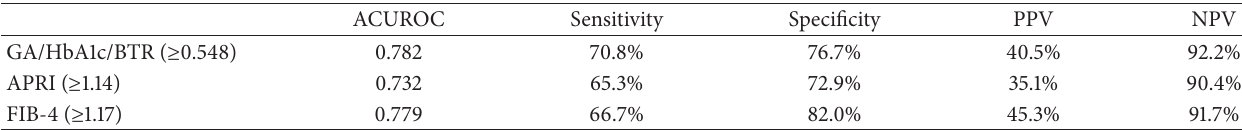
Table 4: Comparison of three biomarkers for the prediction of liver cirrhosis.